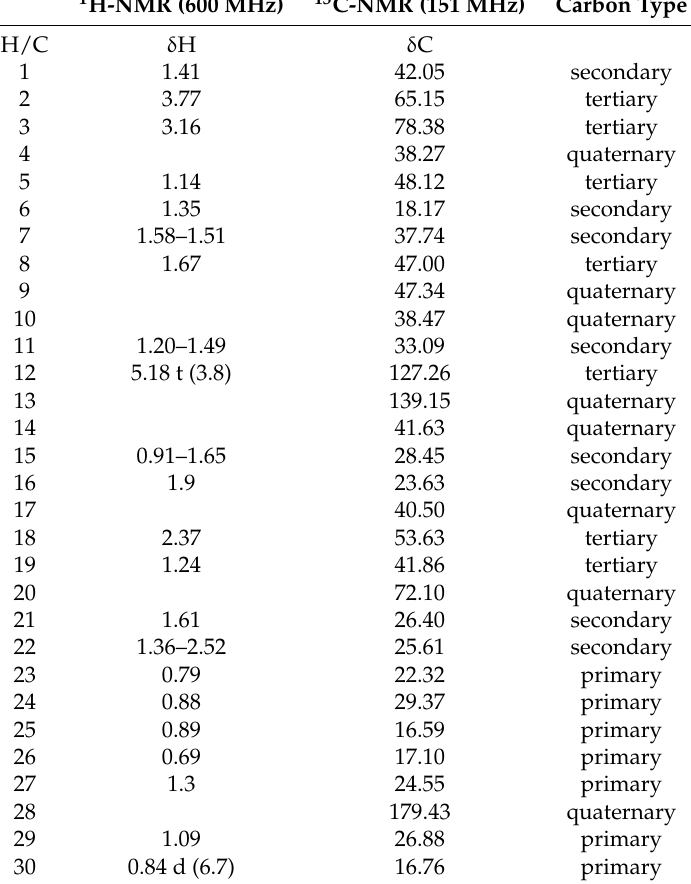
Table 2. NMR assignments for isoyarumic acid. Data are ordered according to the numbering of the chemical nucleus in Figure 4. Columns list the chemical shifts of both the nucleus and the carbon